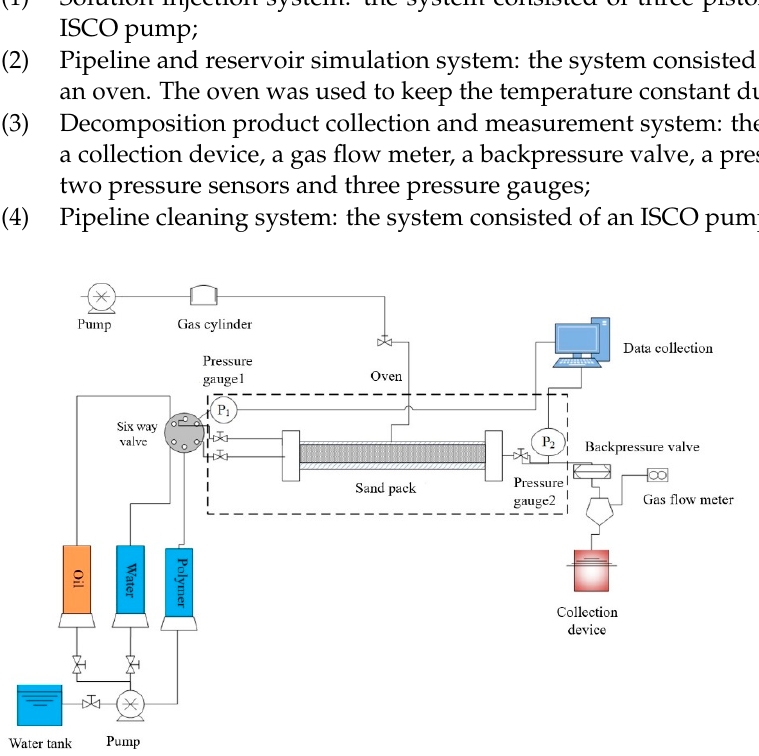
Figure 4. The flowchart of the physical model displacement